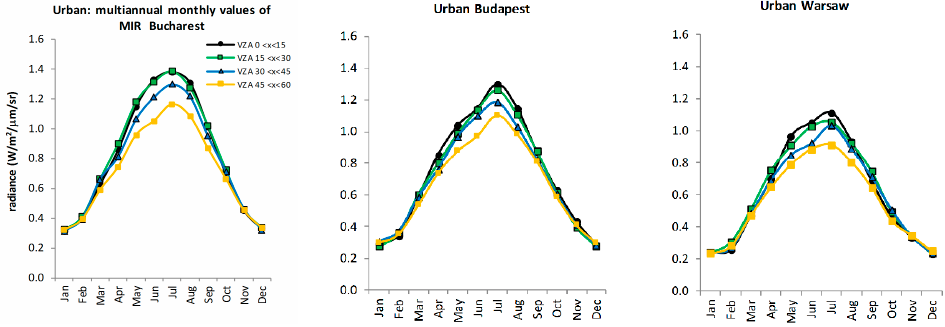
Figure 7. Mean monthly values of MIR radiance in four VZA classes for the urban cover class.